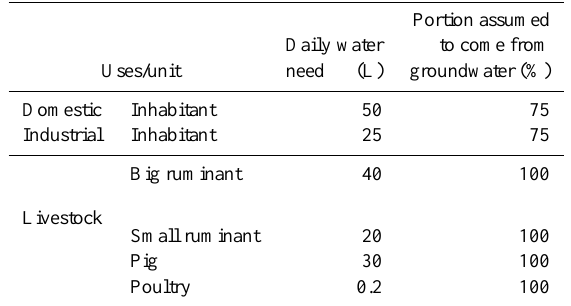
Table 3. Other groundwater uses (adapted from Pavelic et al., 2013).